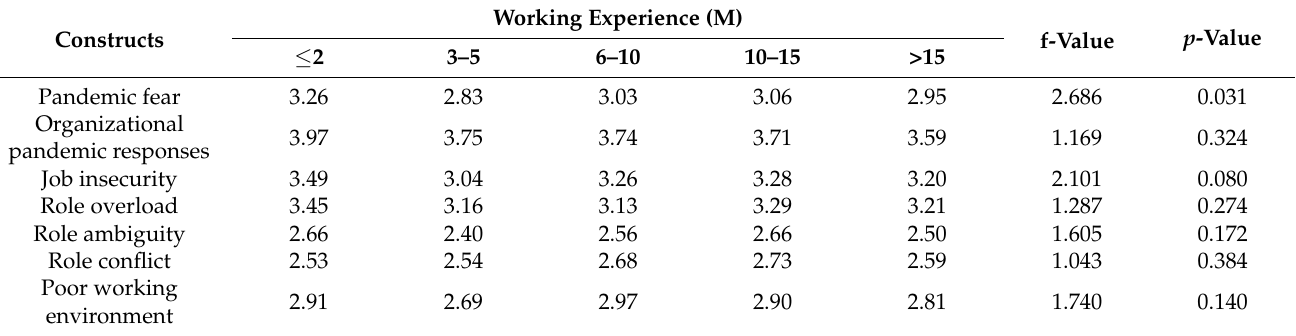
Table 9. ANOVA analysis of working experience.